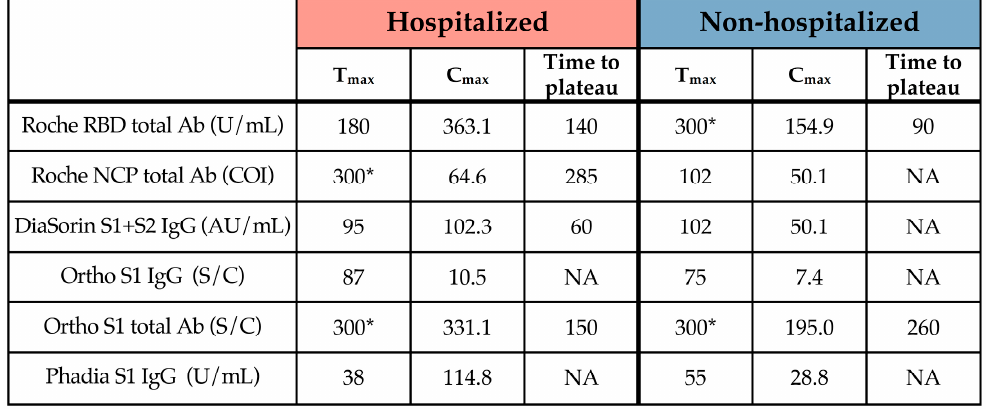
Table 3. T max , C max and time to plateau of the six assays subdivided into hospitalized and non- hospitalized patients. * corresponds to the last time point assessed.